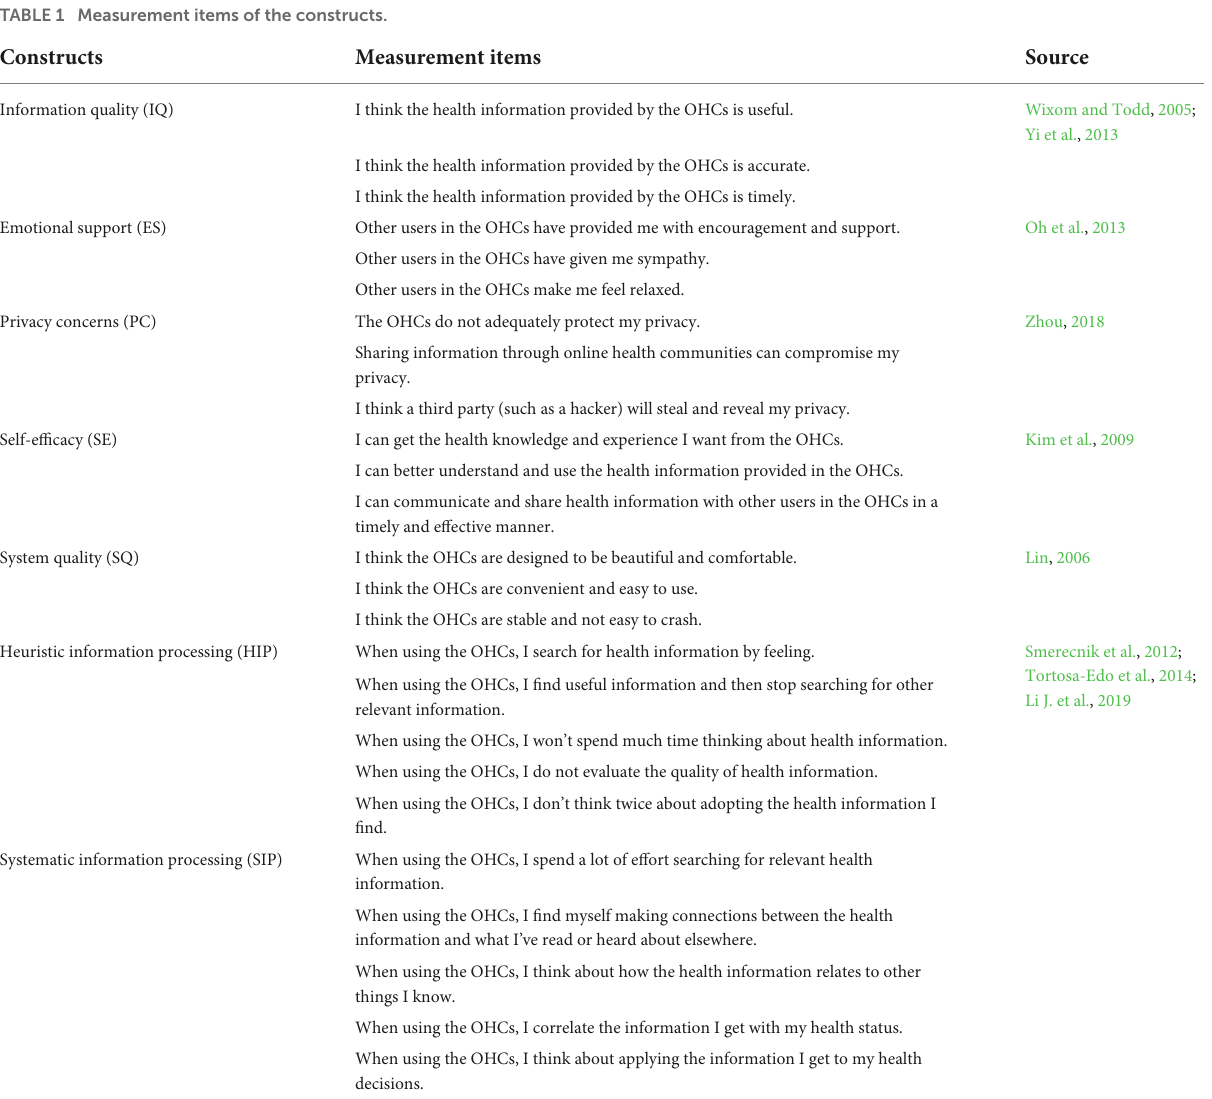
TABLE 1 Measurement items of the